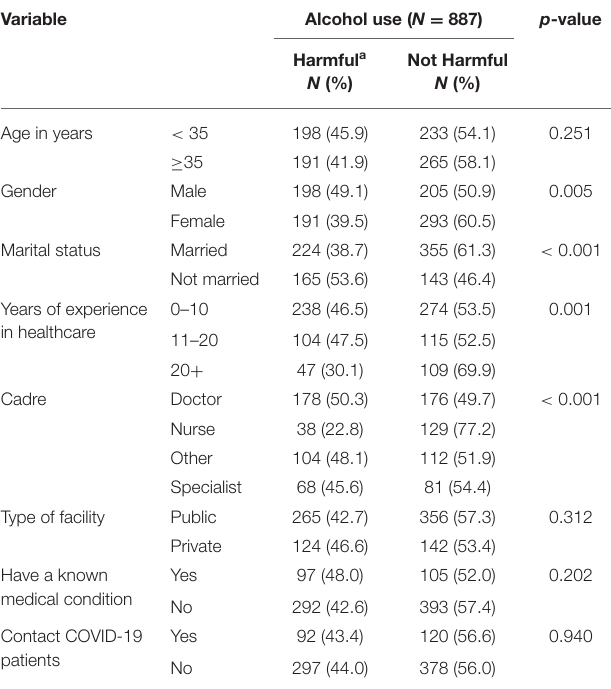
TABLE 2 | Mental health characteristics of the participants who completed the AUDIT. Depression a ( N = 858 b )